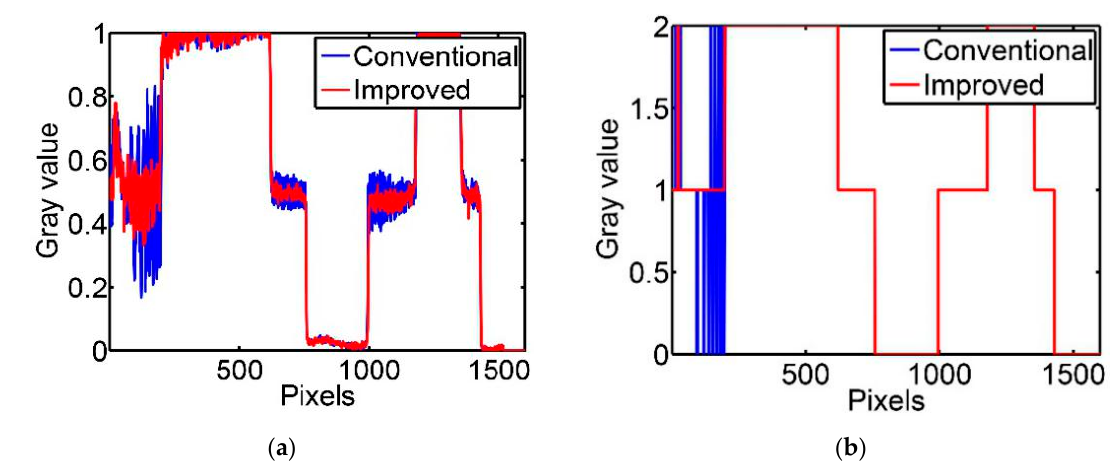
Figure 7. ( a ) The cross sections of the normalized intensity for the third coding pattern; ( b ) The respectively detected codewords.